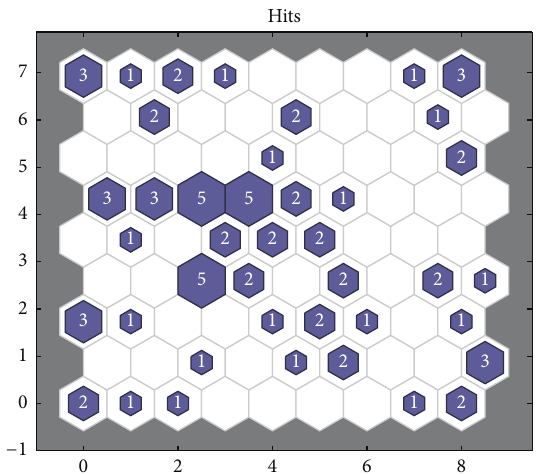
Figure 15: Statistics chart of winning neurons of SOM neural